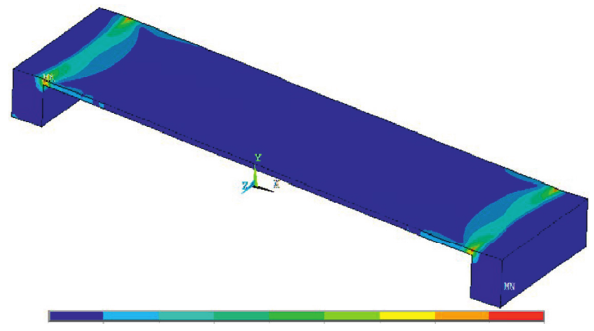
Figure 13: Von Mises equivalent stress distribution on the main girder section for the damaged case (unit: